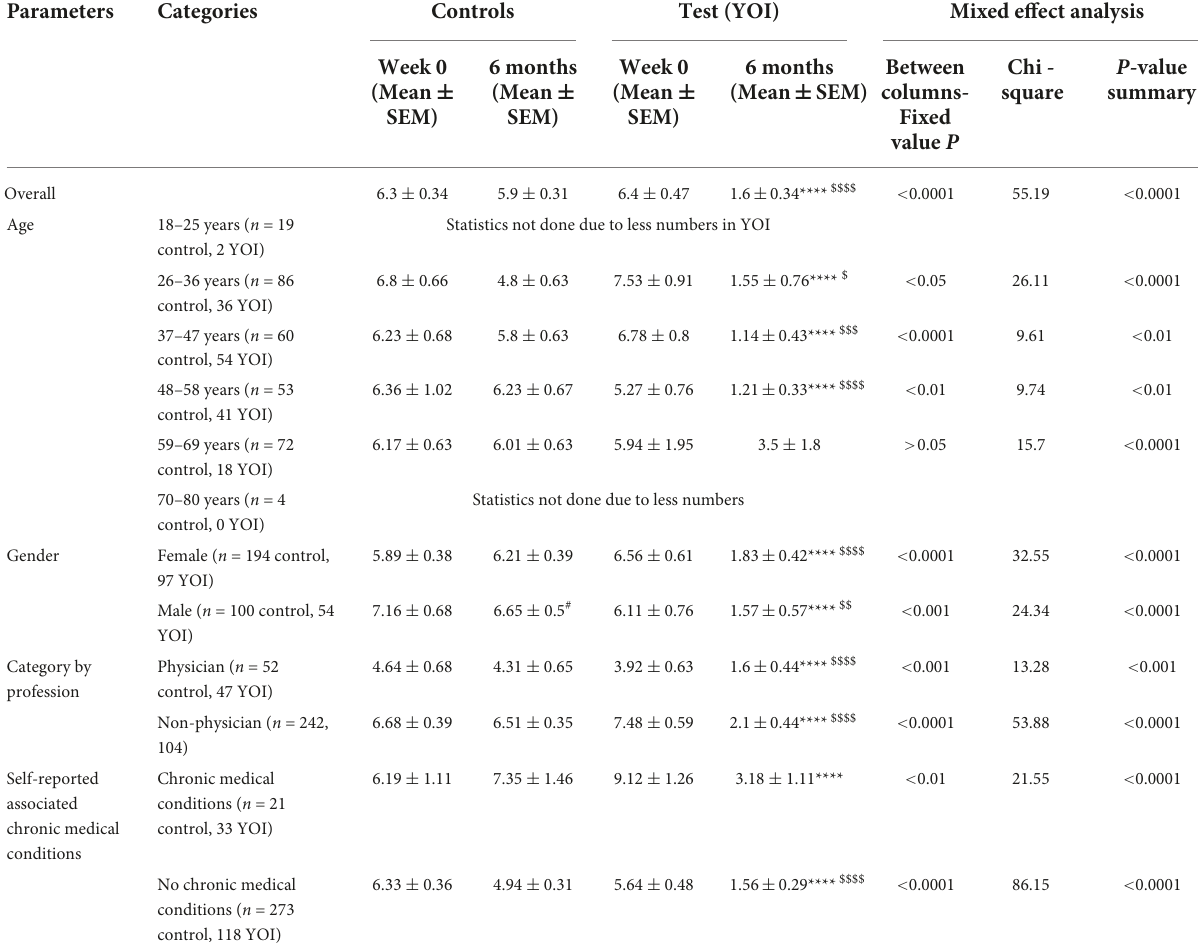
TABLE 4 Overall mean total PHQ-8 score and mean total PHQ-8 scores for demographic parameters in control and YOI